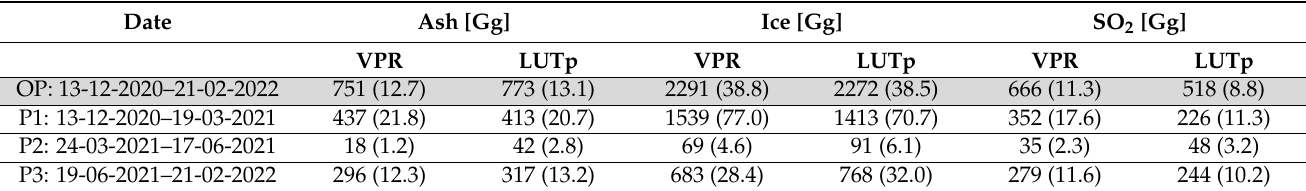
Table 1. Cumulative and average (in brackets) ash/ice/SO 2 total masses in the overall period (OP) December 2020–February 2022 (upper row) and the three specific periods identified (P1, P2, and P3), both from VPR and LUT p